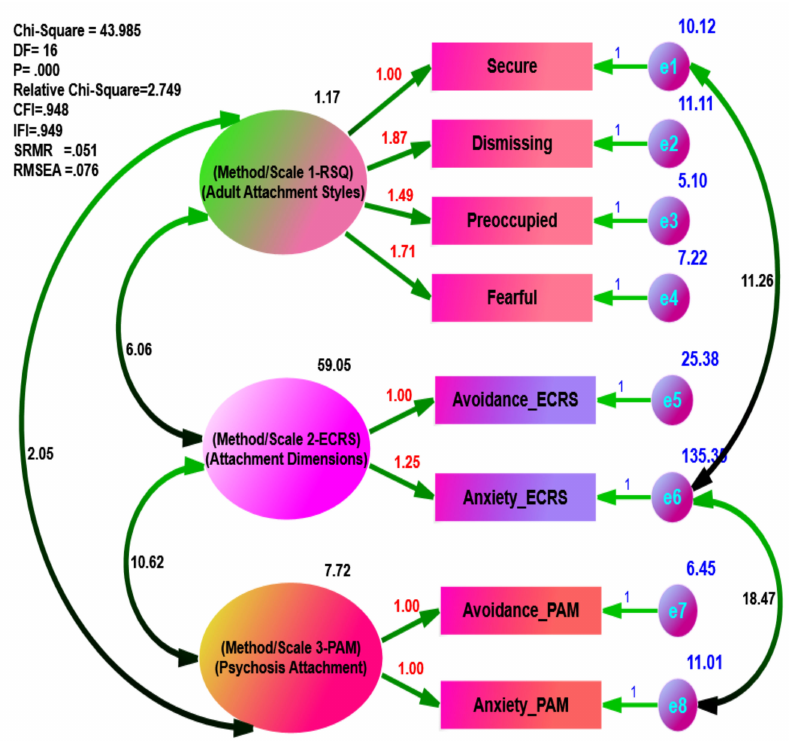
Figure 4. Multi-Methods of Hypothesized Measurement Models of the Attachment Theory in Non- Psychiatric